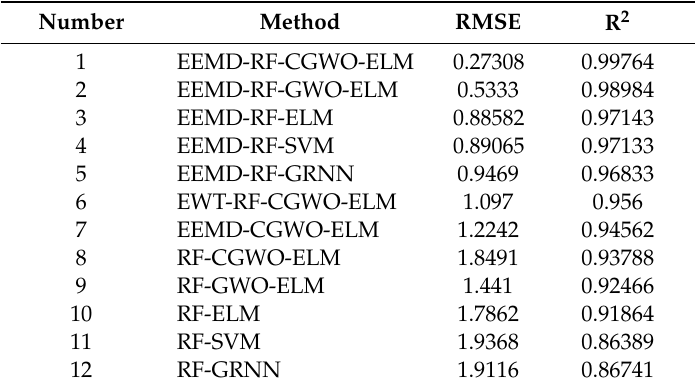
Figure 20. Comparison of 12 prediction results of “front flat line 95.” Table 6. Prediction method error analysis table of “front flat line